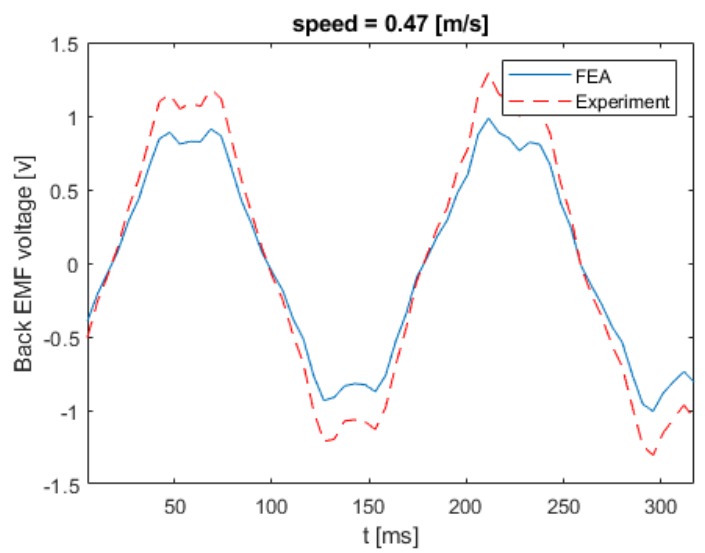
Figure 18. Back EMF voltage for linear speed of 0.47 m / s.